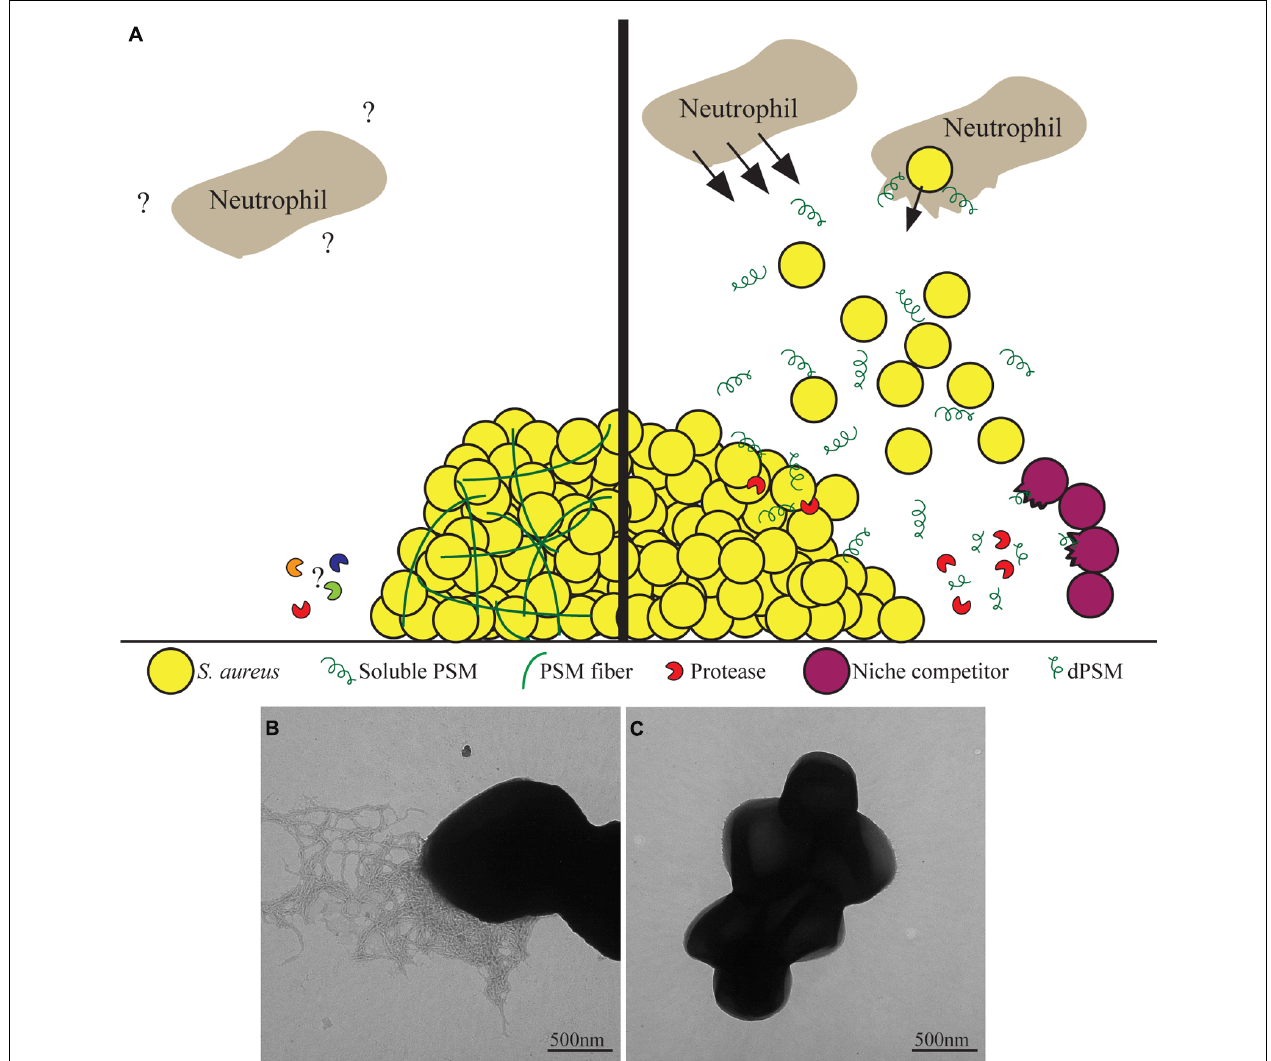
(dPSMs) that can kill niche competing bacteria. Once polymerized into amyloid fibers, PSMs provide functional support to the biofilm community that prevents degradation by biofilm dispersing enzymes. The interactions between PSM fibers and immune cells have yet to be characterized. (B) Transmission electron microscopy of a S. aureus biofilm that is producing PSM amyloids fibers. (C) S. aureus biofilm cells under conditions where amyloid fibers are not